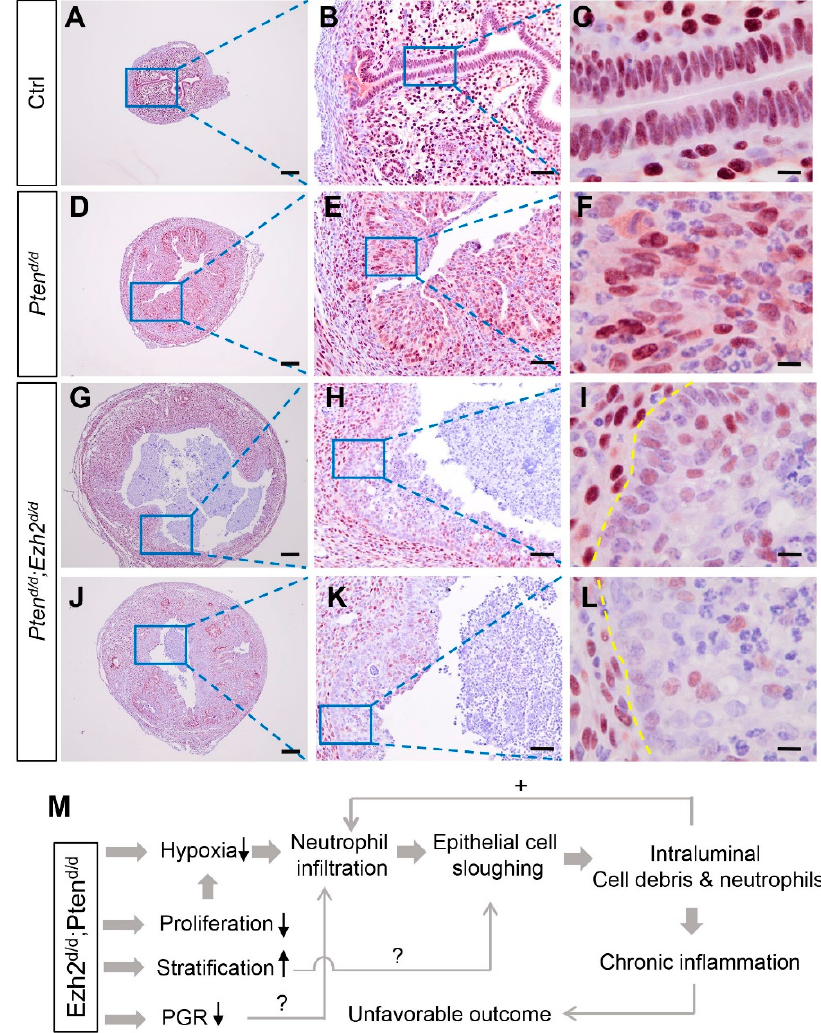
Figure 8. Expression of PGR in Pten d/d and Pten d/d ; Ezh2 d/d uteri. ( A – L ) Immunostaining of PGR in the uteri of 1-month-old Pten f/f (Ctrl), Pten d/d , and Pten d/d ; Ezh2 d/d mice. Panels ( G – I ) and Panels ( J – L ) represent two independent Pten d/d ; Ezh2 d/d mice with different disease progression. Panels ( B , E , H , K ) are high power images of the boxed areas of panels ( A , D , G , J ), respectively. Panels ( C , F , I , L ) are high power images of the boxed areas of panels ( B , E , H , K ), respectively. At least three independent samples were examined for each genotype. Scale bar = 10 µ m ( C , F , I , L ), 50 µ m ( B , E , H , K ), and 200 µ m ( A , D , G , J ). Yellow dashed lines demarcate the border between uterine stroma and epithelia. ( M ) A hypothetical model of endometrial cancer development in mice harboring uterine deletion of both Pten and Ezh2 .